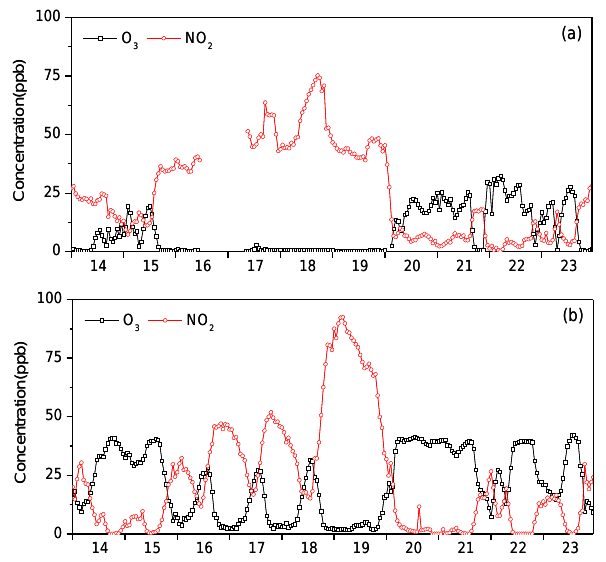
Fig. 7. Time series variations of O 3 and NO 2 at (a) BJ and (b) SDZ from 14 to 23 January 2010. Fig.7. Time series variations of O